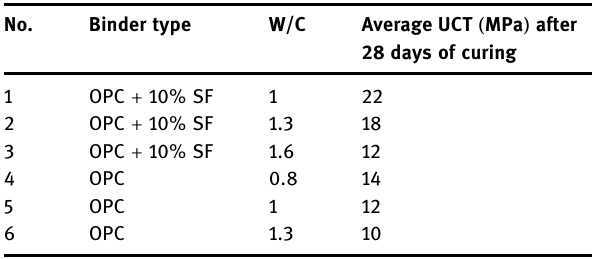
Table 2: Average UCT results of grouted cement and chemical grouted columns samples